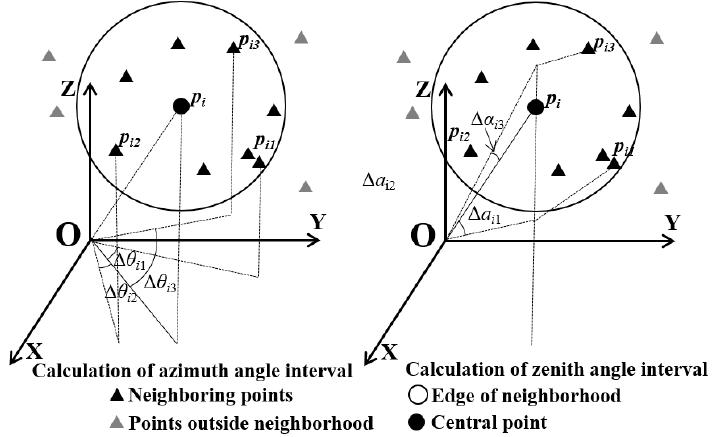
Figure 4. Calculation of azimuth and zenith angle interval between one point and its neighboring points.